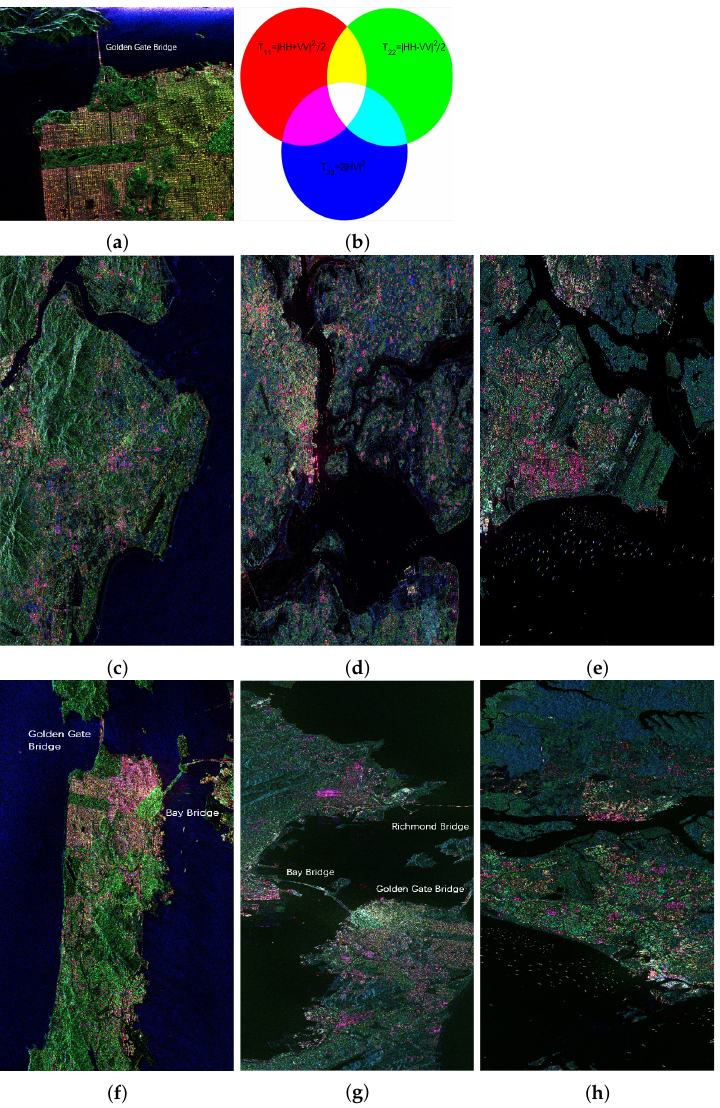
Figure 3. The Pauli pseudo-color images of the experimental data. ( a ) AirSAR San Francisco. ( b ) The color code of the Pauli image, where “R”, “G”, and “B” denote the three components of the Pauli vector, respectively, and ( HH , VV , HV ) are the three components of the Sinclair matrix. ( c ) RADARSAT-2 Fuzhou. ( d ) RADARSAT-2 Zhanjiang. ( e ) RADARSAT-2 Singapore. ( f )